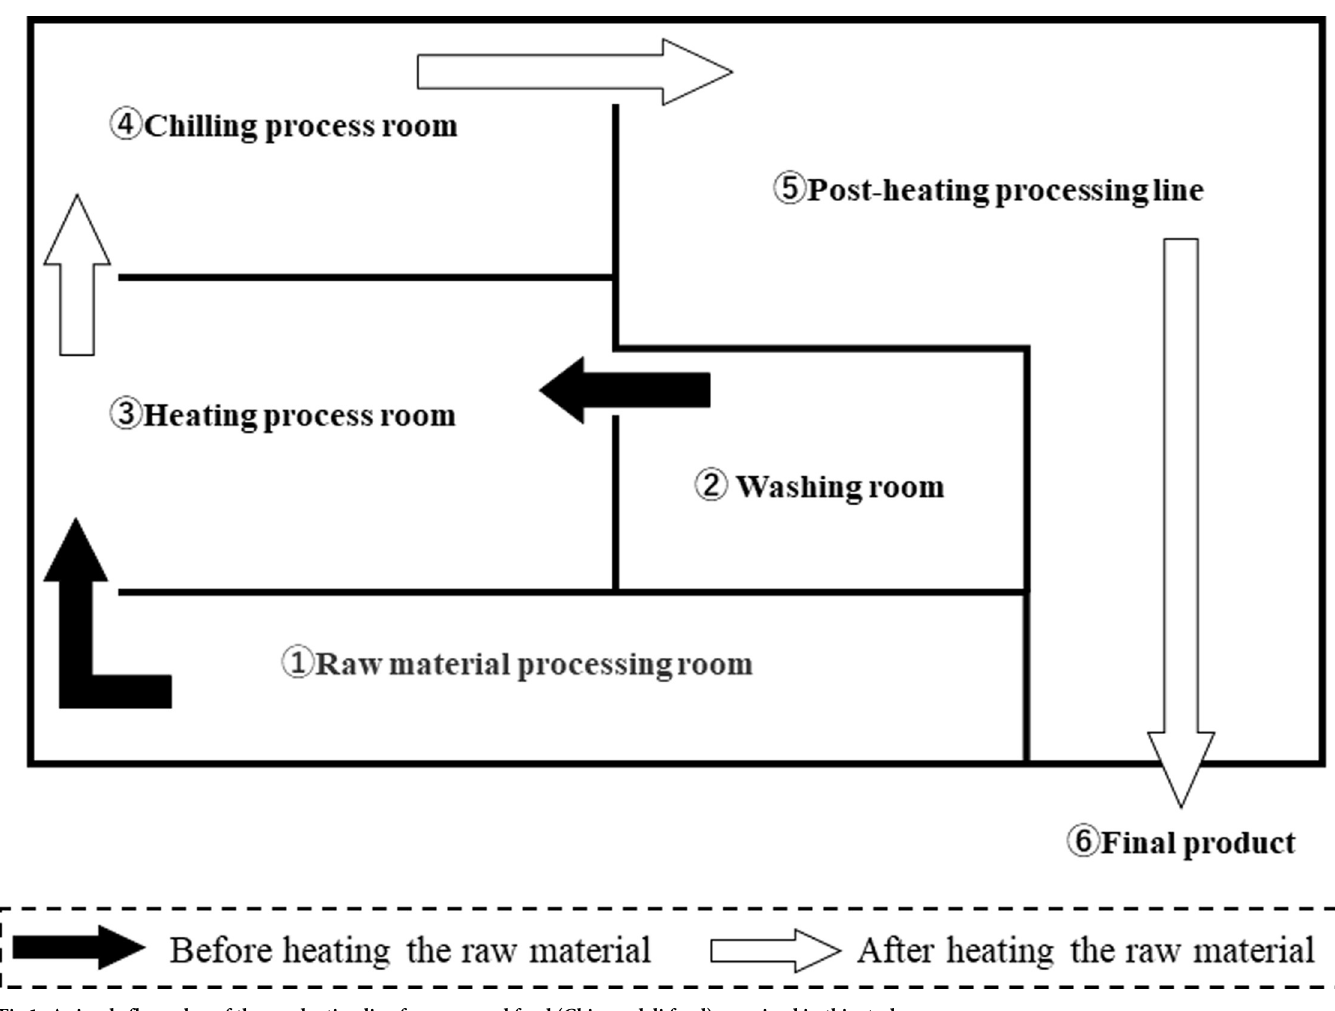
Fig 1. A simple floor plan of the production line for processed food (Chinese deli food) examined in this